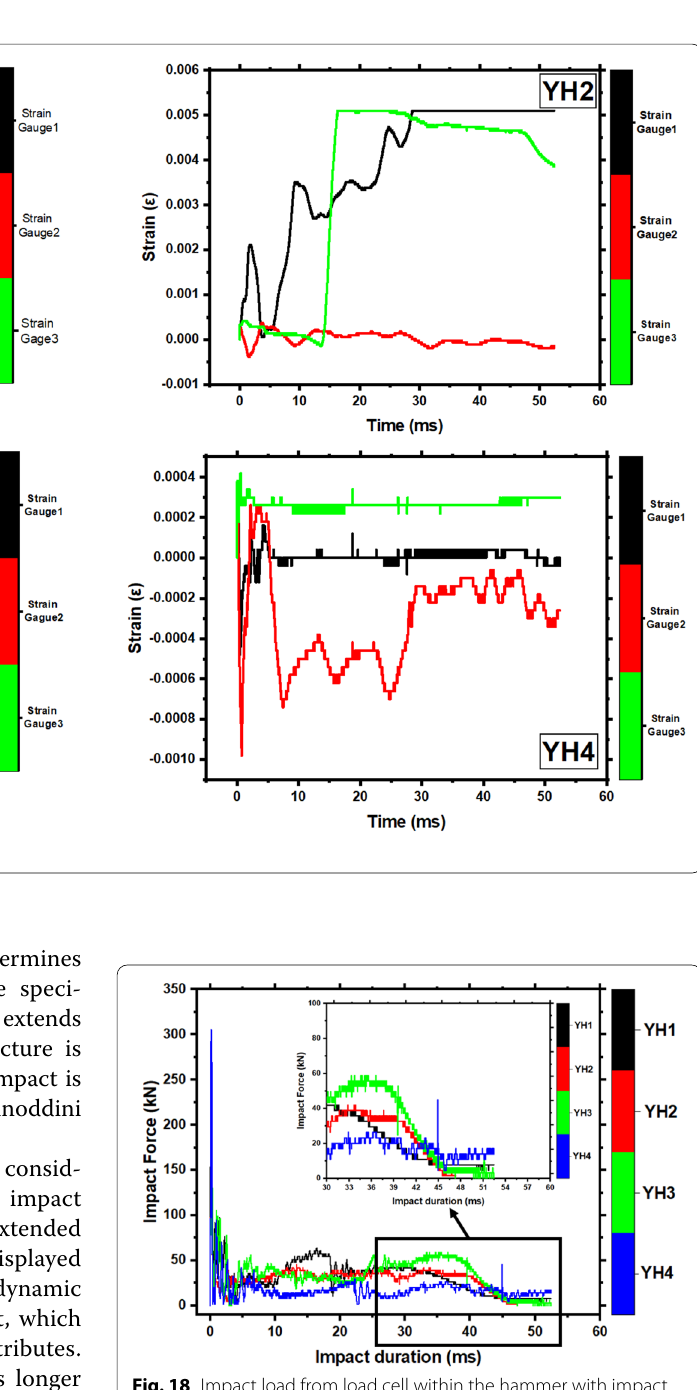
Fig. 18 Impact load from load cell within the hammer with impact duration on